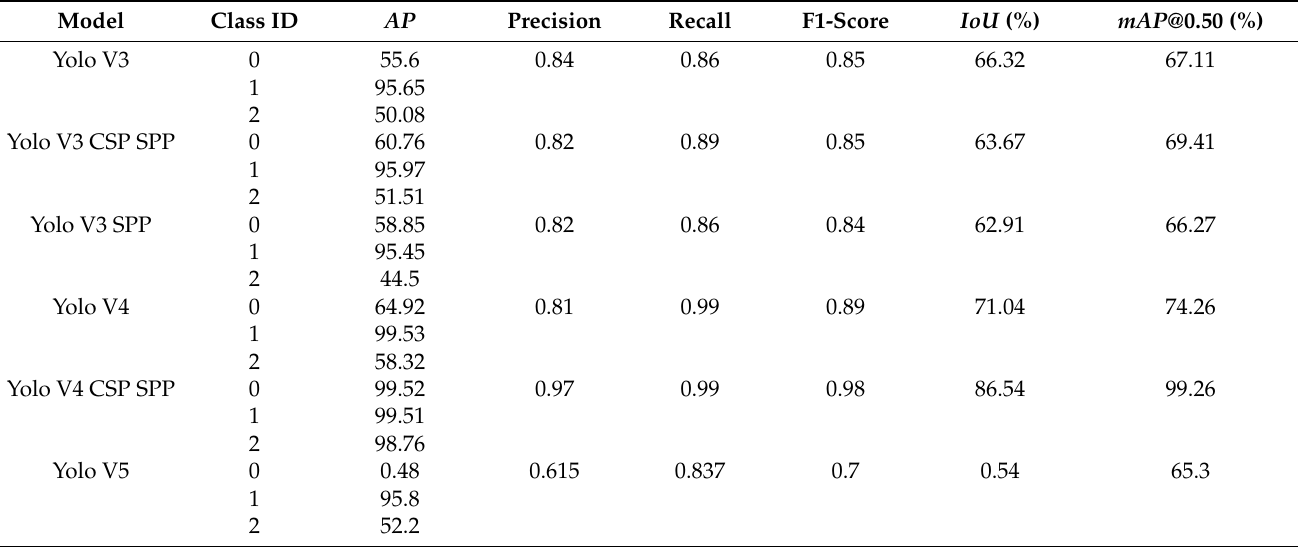
Table 2. Testing accuracy performance for all models with FMD and MMD